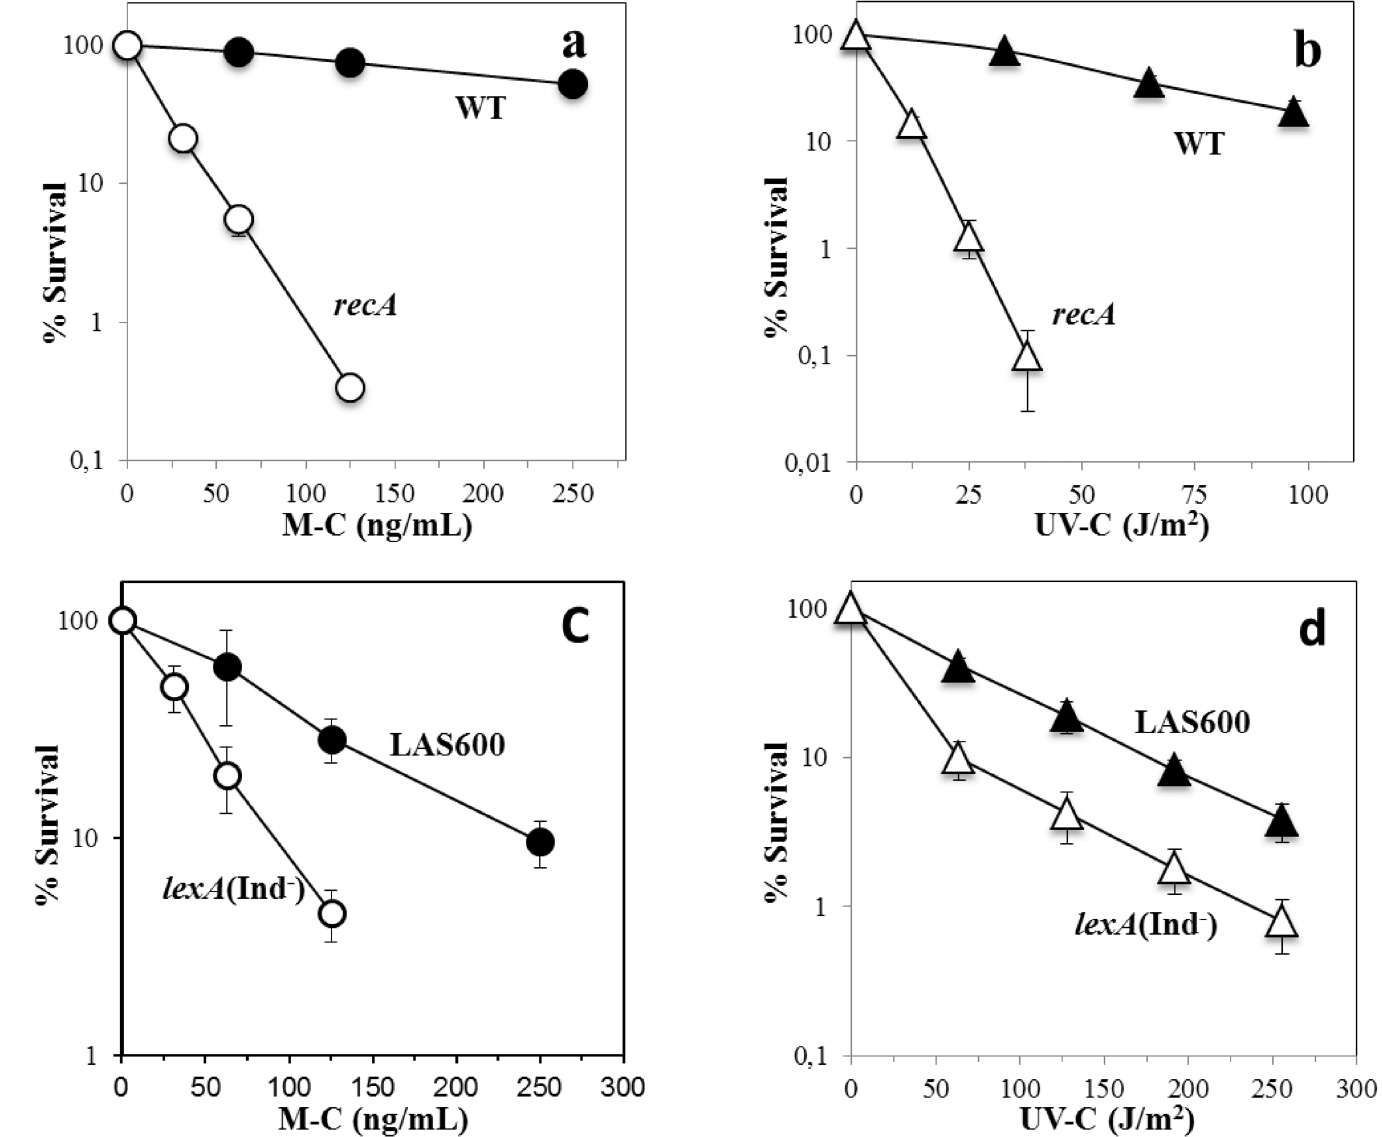
Fig 5. Resistance of Δ recA and SOS-deficient strains to M-C (a, c) and UV-C radiation (b, d) during sporulation. Sporulating cells of strains 168 (wild- type), PERM1030 ( Δ recA ), LAS600 (parental) and LAS523 ( lexA [ind - ]) were treated (open symbols) or not (filled symbols) with increasing doses of M-C (a and c, circles) or UV-C light (b and d, triangles) at 4.5 h (wild-type, LAS600 and LAS523) or 6.5 h ( Δ recA ) after the onset of sporulation, and cell survival was determined as described in Materials and Methods. Data are expressed as the average ± SD of at least three independent experiments.